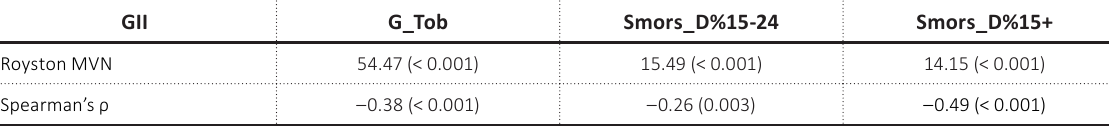
Figure 3. Relationship between GII and Smors_D%15 Table 6. Association